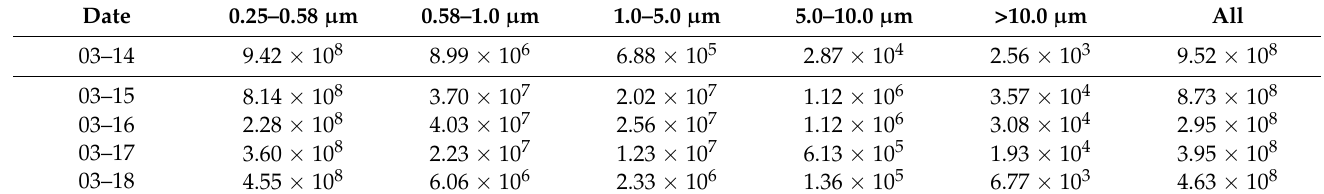
Figure 10. Number concentration of different particle size varying with time. Table 2. Number of particles in each size interval during the dust process. Table 2. Number of particles in each size interval during the dust process.